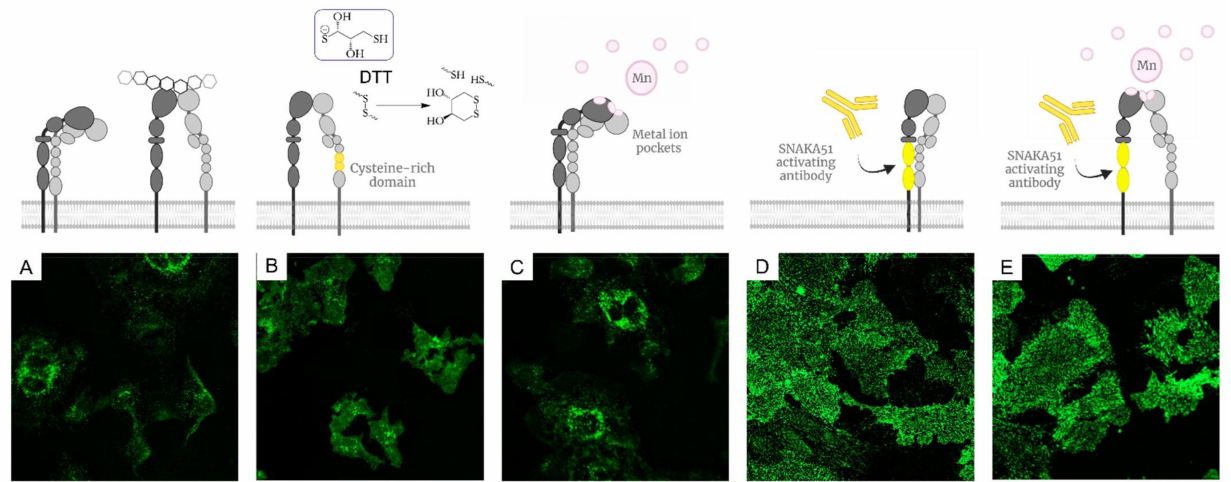
Figure 1. Methods for integrin α 5 β 1 activation. Fluorescence microscopy images ( A – E ) show the re- sulting staining of fluorescently labeled SNAKA51 on HUVECs ( A ) in resting conditions ( B ) activated with DTT ( C ) in presence of Mn 2+ ( D ) following initial SNAKA51 incubation ( E ) in combination of SNAKA51 and Mn 2+